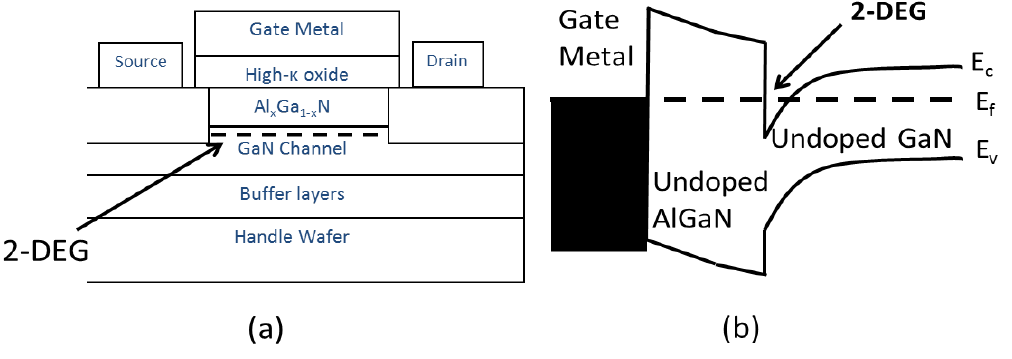
Figure 1. ( a ) Example of a commercial AlGaN/GaN high electron mobility transistors (HEMTs) structure; ( b ) Band